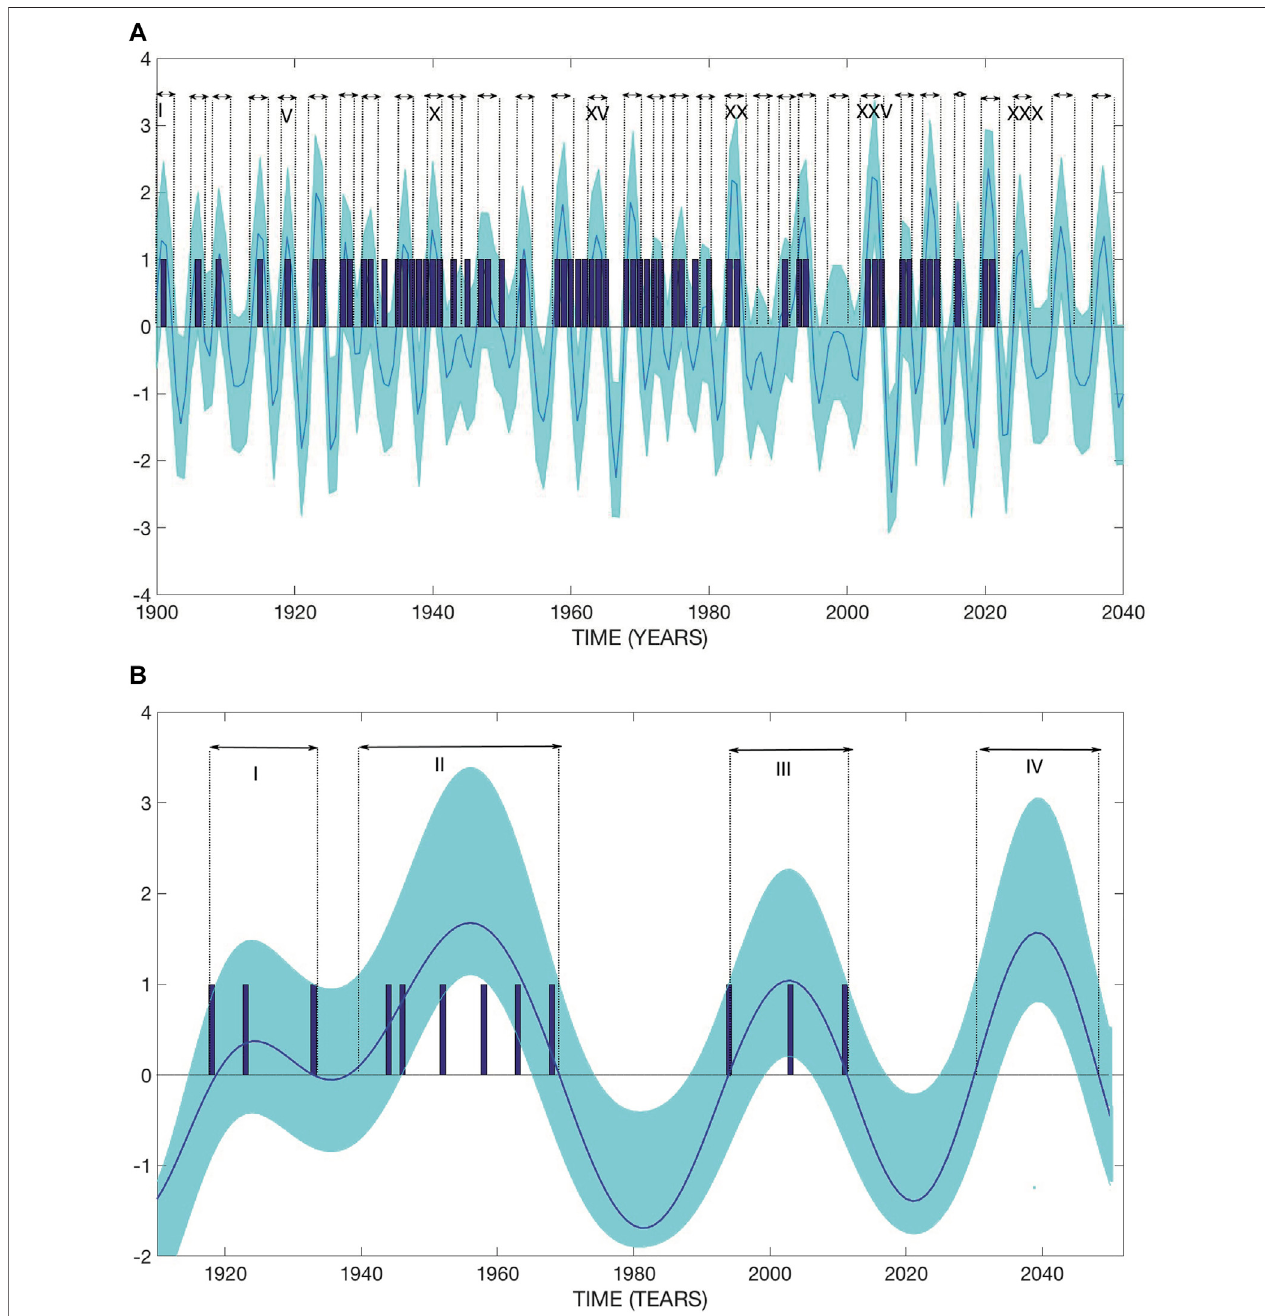
FIGURE 11 | (A) Probabilistic earthquake prediction for Japan with magnitudes 7 ≤ M < 8. Bayesian inference of LS-SVM model (blue line and shade) compared with the historical Japanese earthquakes clustered in twenty nine groups (I-XXIX) and shown with vertical blue bars from 1900 to 2021. In addition, the probabilistic earthquakepredictionisshownforthefollowingthreeperiods(clusterXXX-XXXII). (B) ProbabilisticearthquakepredictionforJapanwithmagnitudegreaterthanorequal to8.Bayesian inference ofLS-SVMmodel(bluelineandshade) compared withthehistoricalJapaneseearthquakesclusteredinthreegroups(I-III)andshown with verticalbluebarsfrom1900to2021.Inaddition,theprobabilisticearthquakepredictionisshownforthefollowingperiod(clusterIV).Theblueshadedarearepresentsthe 95% con fi dence intervals of the Bayesian